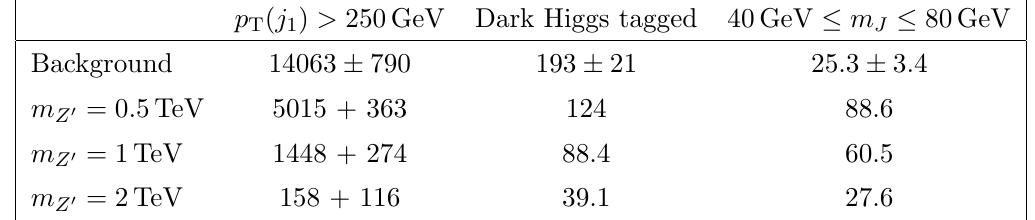
Table 2 . Cut (cid:13)ow for signal and background events. The entries give the expected number of events with =E > 500 GeV at 40 fb (cid:0) 1 for successively more stringent cuts on the leading jet. For T the background predictions we also provide the combined statistical and systematical